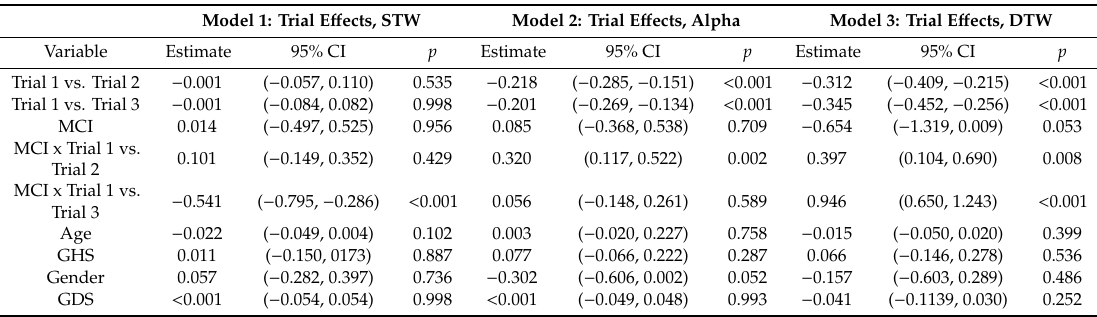
Table 2. Linear-Mixed-Model Estimates of Trial E ff ects on fNIRS-Derived HbO 2 in STW, Alpha and DTW. Model 1: Trial E ff ects, STW Model 2: Trial E ff ects, Alpha Model 3: Trial E ff ects,